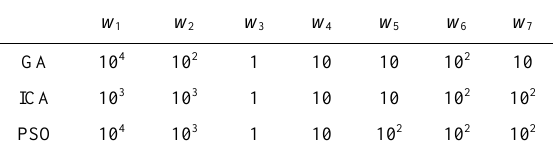
Table 1. Different weight values of cost function for GA, ICA, and